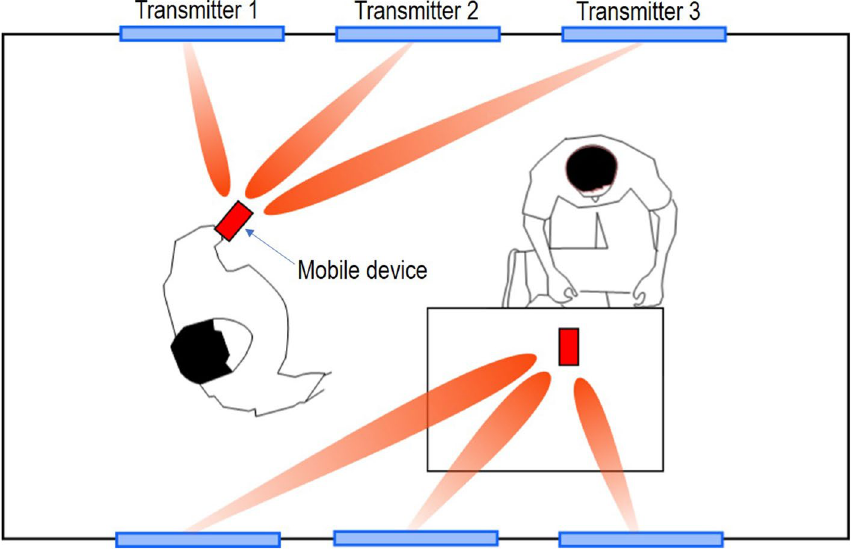
Figure 1. An example showing a wireless power transmission grid for home use application for continuous powering of mobile devices. Figure drawn using Inkscape 1.1 available from https:// inksc ape.